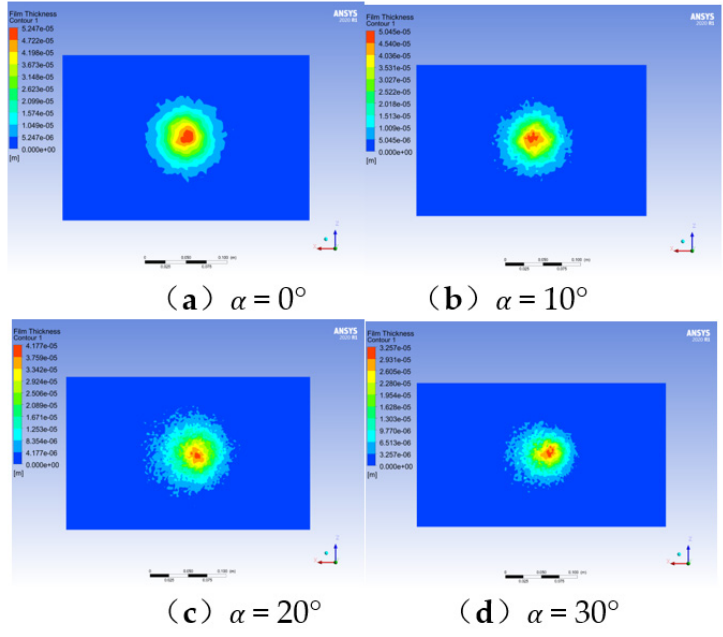
Figure 6. Film thickness distribution with different dip angles.